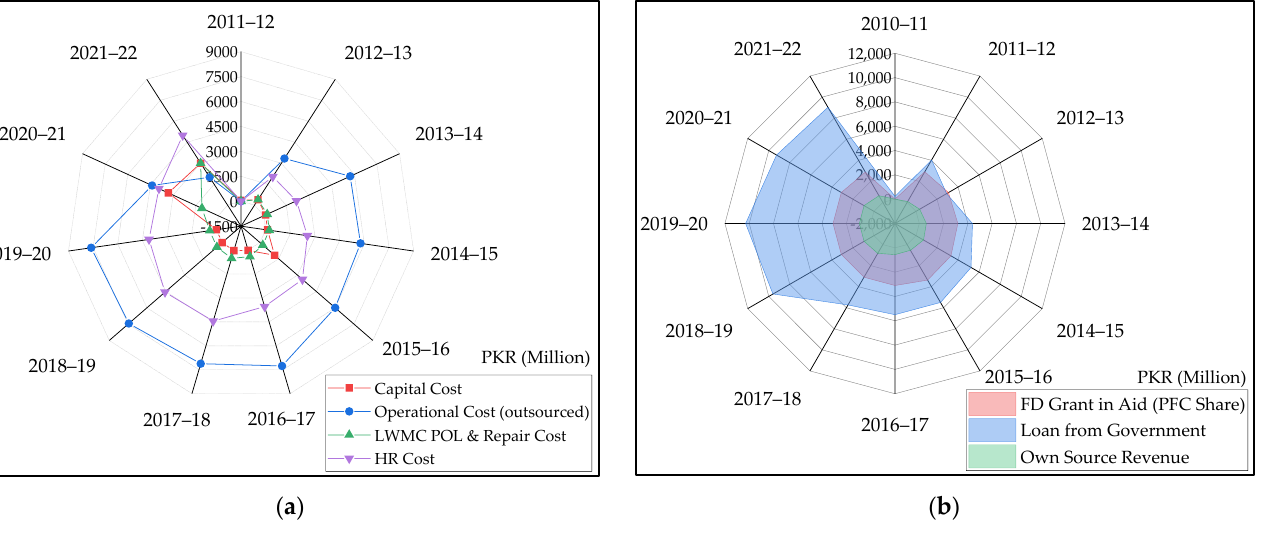
Figure 18. Funding and expenditure detail of city cleaning operation [121]: ( a ) Year-wise expenditure details on cleanliness operation; ( b ). Year wise receipt details to perform cleanliness operation the city.